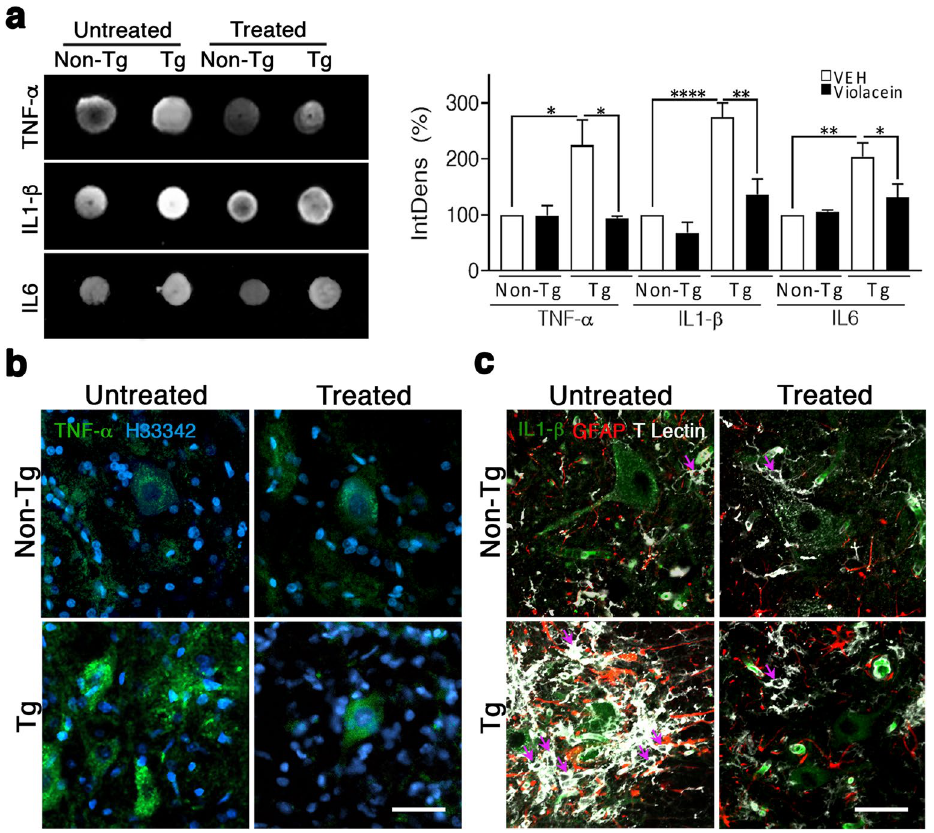
Figure 6. Low levels of inflammatory cytokines in spinal cord of Tg-treated rats. ( a ) Dot blot assays showed TNF-α, IL-1β and IL6 increased signals in spinal cord homogenates of Tg-untreated versus Non-Tg rats, and decreased signals upon violacein treatment. The chart showing the quantitated integrated density parameterized to Non-Tg-untreated samples confirmed increased values in Tg-untreated for TNF-α (p = 0.0197), IL-1β (p < 0.0001), and IL6 (p = 0.0015), respectively. Similar levels were seen in Tg-treated versus Non-Tg samples for TNF-α (p = 0.9991), IL-1β (p = 0.1905) and IL6 (p = 0.7290), respectively. The amount of protein used per spot was 30 µg. ( b ) Representative confocal Z-stack images of TNF-α immunofluorescences in spinal cord sections from each experimental condition. Low but specific cytoplasmic signal (green) was seen in some motor neurons from Non-Tg rats independently on violacein treatment. Instead, in Tg-untreated section, TNF-α brighter signals were observed in more motor neurons and widespread inside the spinal cord parenchyma. In the Tg-treated section, TNF-α staining was very similar to that of Non-Tg samples. Cell nuclei were labelled with Hoechst 33342. ( c ) Z-stack images of immunofluorescences against IL-1β (green), GFAP (red) and Tomato lectin (white) from all experimental groups. Non-Tg sections showed low but specific IL-1β expression in motor neurons and blood vessels. No significant signals were seen in astrocytes or microglial cells (magenta arrows). Instead, in the Tg-untreated section, more IL-1β positive motor neurons were seen as well as extracellular positive signals together with exacerbated glial reactivity throughout the spinal cord parenchyma. Some reactive astrocytes may express low IL-1β levels as suggested by the presence of yellow/ orange spots. Exacerbated reactive microglia appeared with swollen cell bodies and negative to IL-1β. Upon violacein treatment, IL-1β signal in the Tg-treated section seemed restricted to motor neurons at lower levels than Tg-untreated samples and blood vessels remained highly positive. In this section, glial reactivity was dramatically lower than in Tg-untreated samples as evidenced by the presence of few hypertrophic astrocytes and microglial cells with signals of low/mid reactivity. Calibration: 50 µm ( b ) and 40 µm ( c ),